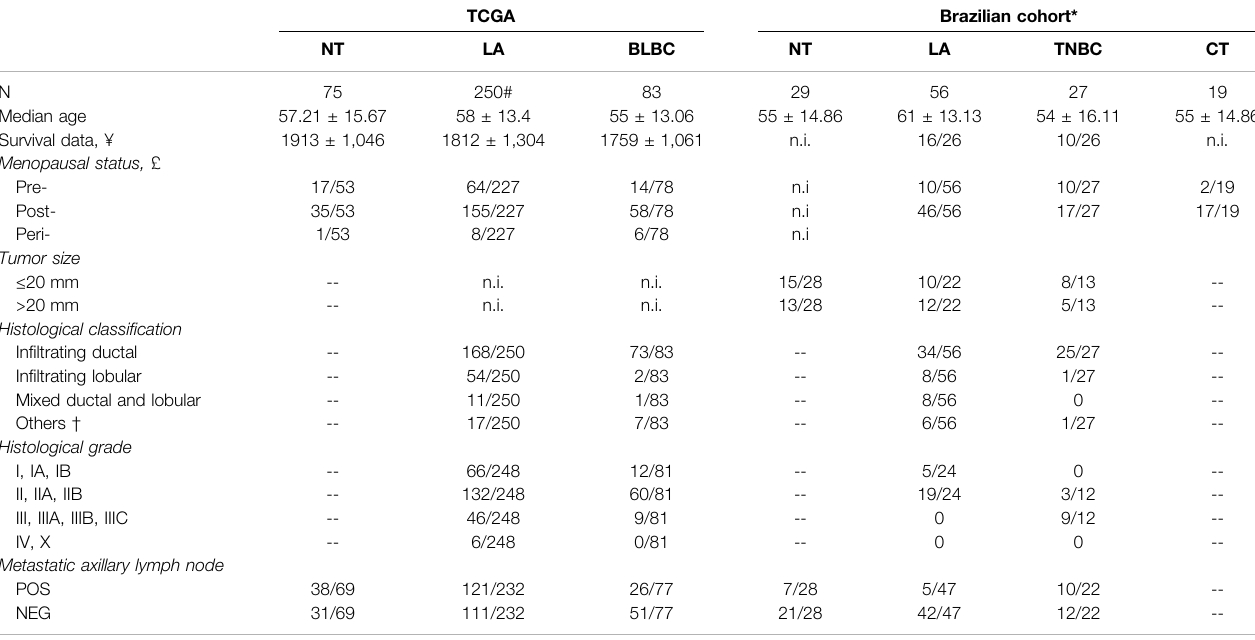
TABLE 1 | Clinicopathological data obtained from the TCGA database and clinical reports of breast cancer